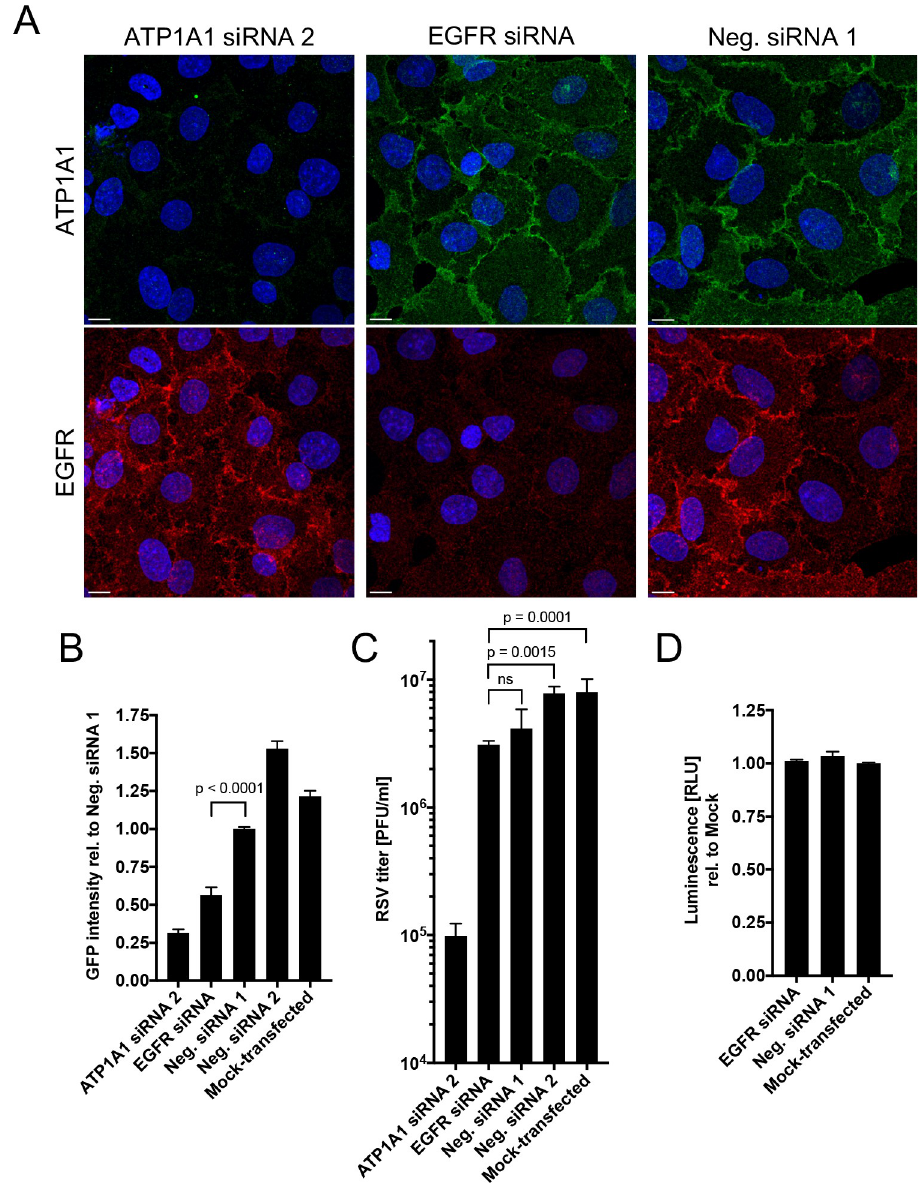
Fig 7. Effect of EGFR knockdown on RSV infection. (A) ATP1A1 and EGFR expression in A549 cells transfected with siRNAs targeting ATP1A1 or EGFR. A549 cells were transfected with ATP1A1 siRNA 2, EGFR siRNA, or Neg. siRNA 1 or 2, incubated for 48 h, and subjected to immunofluorescence staining for ATP1A1 (green) and EGFR (red) as described for Fig 4A. Images (z-stacks) were acquired on a Leica SP5 confocal microscope with 63x objective NA 1.4 and 2.0x zoom. Scale bar 10 μ m. (B and C) EGFR knockdown reduces RSV infection and virion production. A549 cells were transfected with an EGFR-specific siRNA or Neg. siRNA 1 or 2, and 48 h later were infected with RSV-GFP (MOI = 1 PFU/cell). Infection was quantified by (B) GFP signal of the total well, scanned by ELISA reader at 17 h p.i., and RSV production was assessed by (C) plaque titration on Vero cells 24 h p.i. Data are derived from three independent experiments. The statistical significance of the difference was determined by one-way analysis of variance with Tukey’s multiple-comparison post-test and p-values of the significance for each comparison is indicated. (D) Cell viability. An ATP-based cell viability assay (CellTiter-Glo) was performed 72 h p.t. to evaluate the viability of the transfected cells. Cells were lysed, the ATP concentration was determined by luciferase activity relative to mock- transfected cells, as a measure of